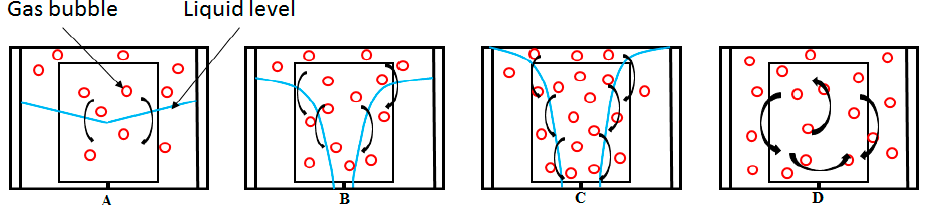
Figure 11. Schematic description of observed flow patterns in open cell. Gas bubbles in red represent the gas phase, and the blue line represents the liquid level in the reactor. Starting at ( A ), at low stirring rates below 350 RPM, the gas liquid contact area is very low. As the stirring rate increases, the liquid level rises, more gas is dispersed into the liquid phase as seen in ( B , C ). At ( D ) the stirring rate is high enough to disperse the liquid within the entire cell volume, obscuring the distinct contact boundary between the gas and liquid phases.